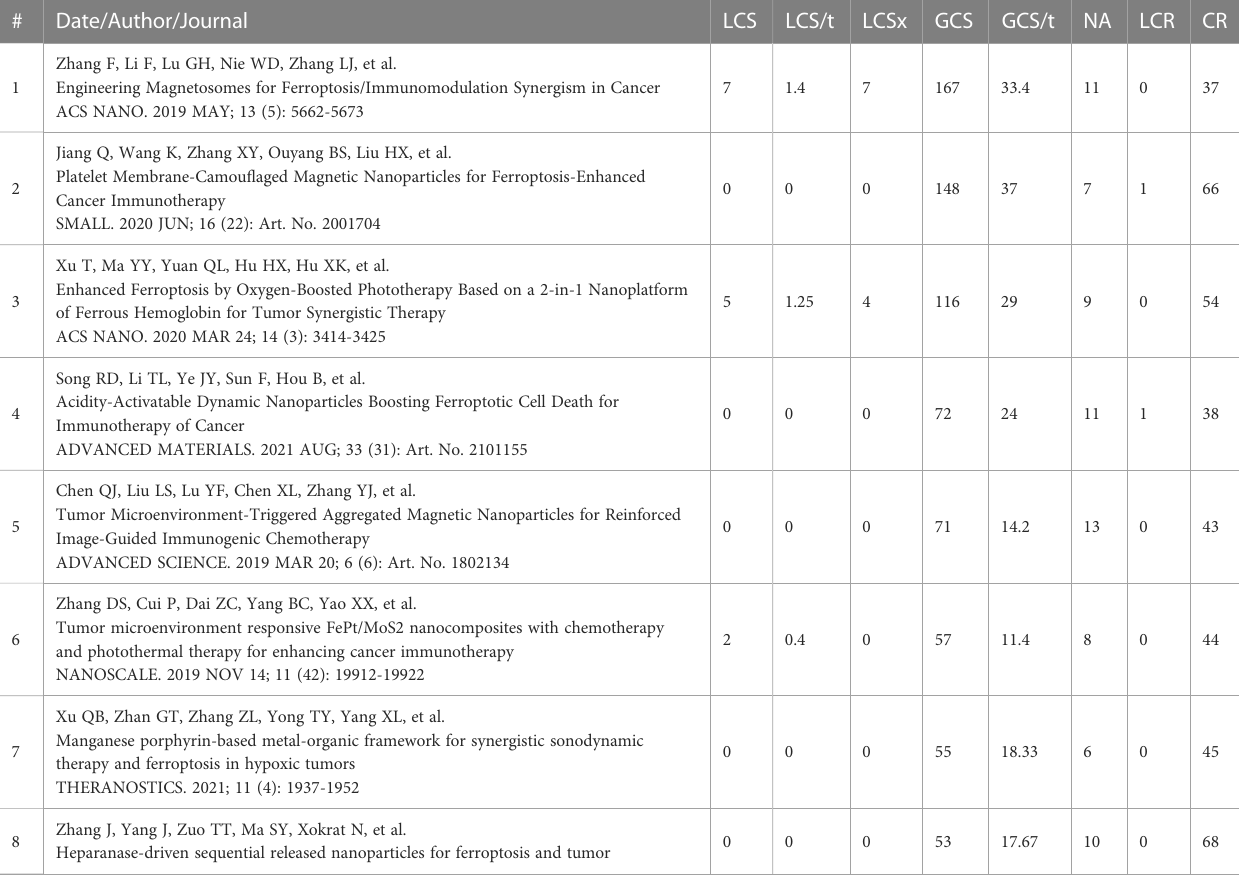
TABLE 4 The top 10 most cited articles in the fi eld of